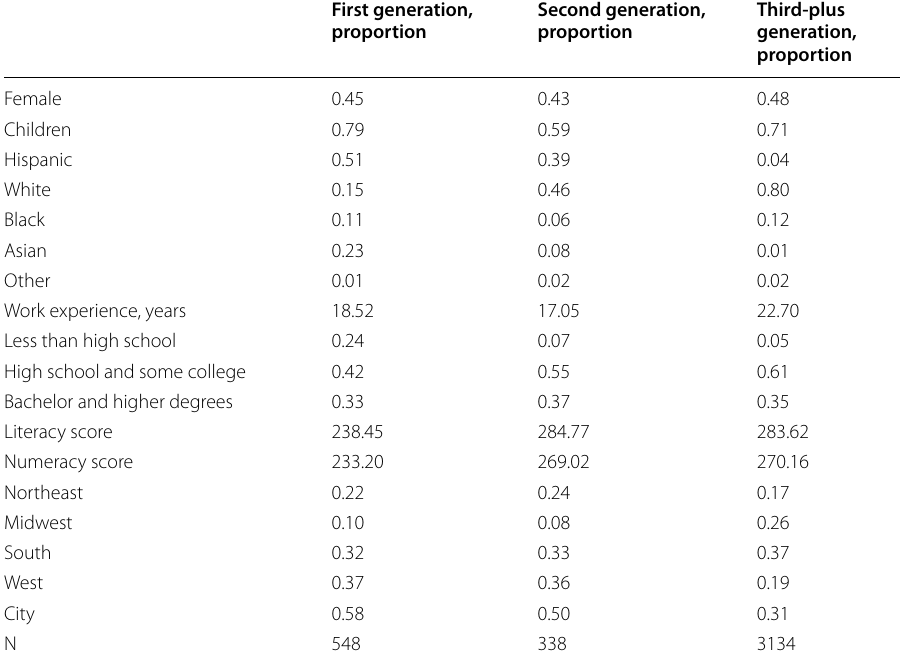
Table 8 Distribution of selected independent variables by immigrant generation, all workers, PIAAC